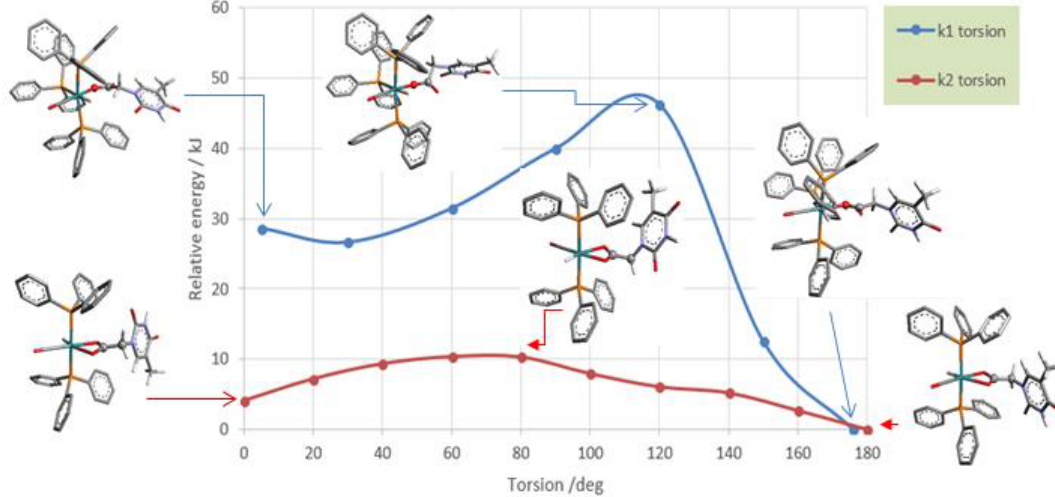
Scheme 3. Calculations on torsional barriers. κ 1 -THAc rotation in 3 takes place along the C-O bond of the acetate group, whereas κ 2 -THAc rotation in 4 is along C-C bond of the THAc-side arm. Only half of the torsion has displayed for